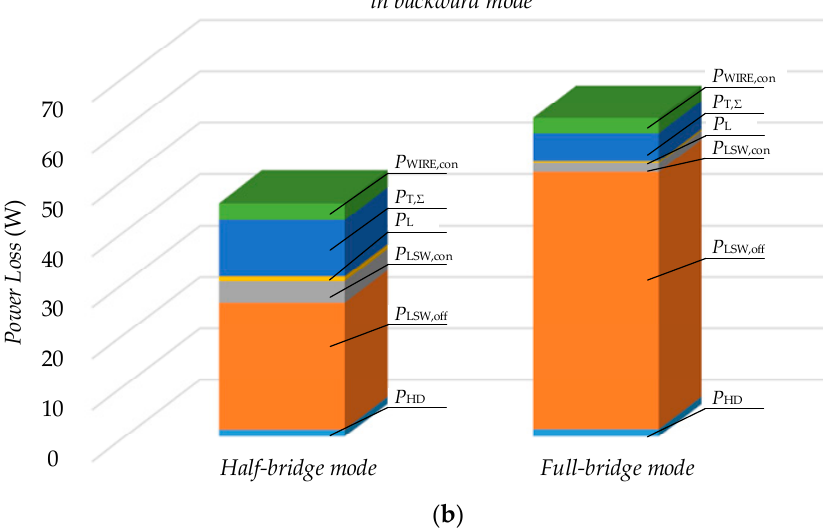
Figure 12. The power loss distribution and comparison between full-bridge and half-bridge configuration with 200 W load: ( a ) forward mode; ( b ) backward mode.